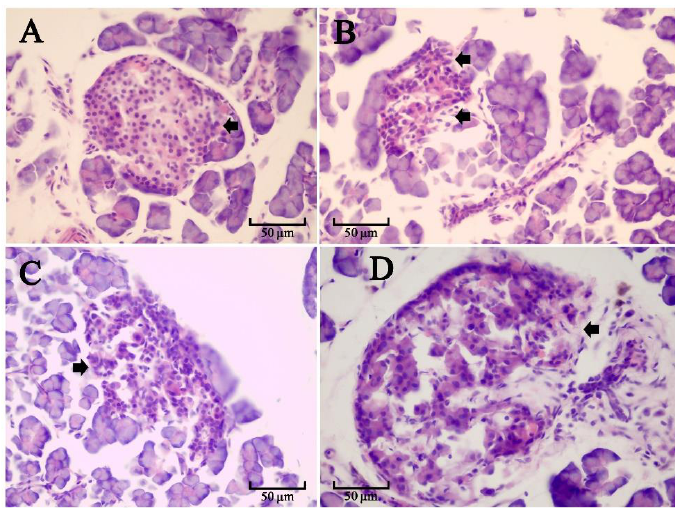
Figure 5. Histological analysis of pancreata from the normal group ( A ), diabetic group ( B ), positive group ( C ) and Scutellariae Radix group ( D ) after four weeks of treatment.